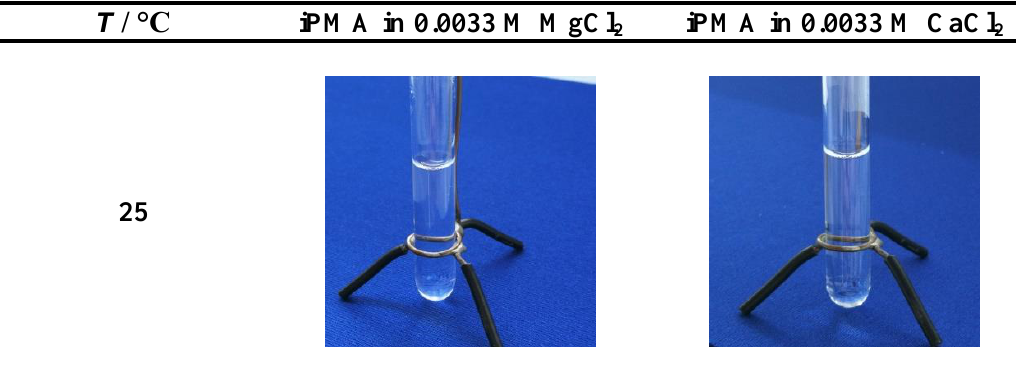
= 0.20) samples in the presence of MgCl N